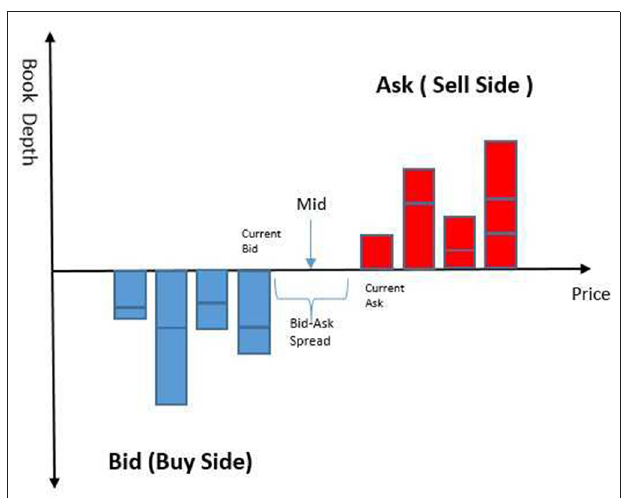
FIGURE 3 | Limit order